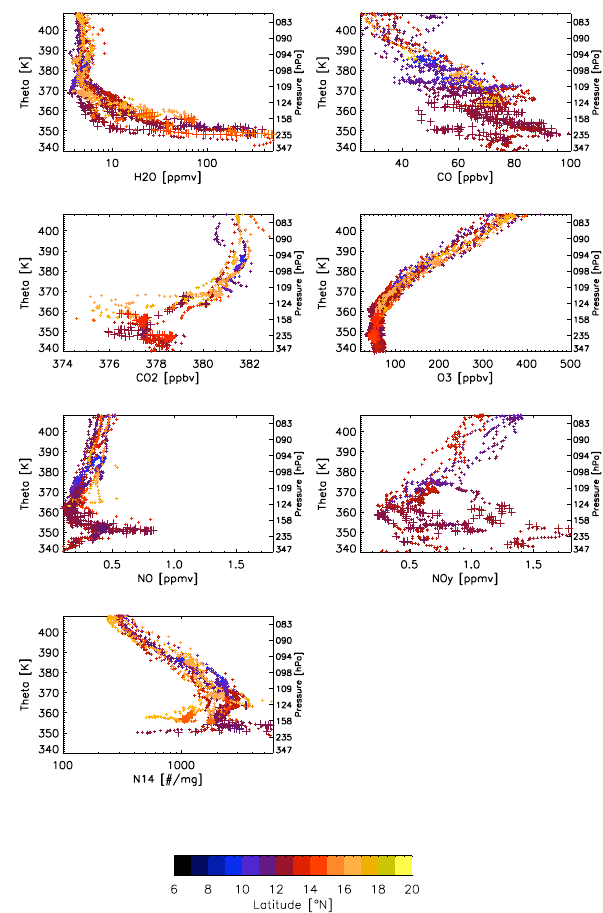
Fig. 10a. Vertical profiles of trace gas concentrations (volume mix- ing ratio in ppbv orppmv as appropriate) and aerosol mass mixing ratios (particles per mg air), N 14 (14nm to < 1µm), for “convective” M55 flights on 7, 8 and 11 August 2006. Profiles are plotted as a function of theta (K) and coloured by latitude where the measure- ments were made. Crosses indicate points where back trajectories show uplift from below 800hPa during 10 days before the